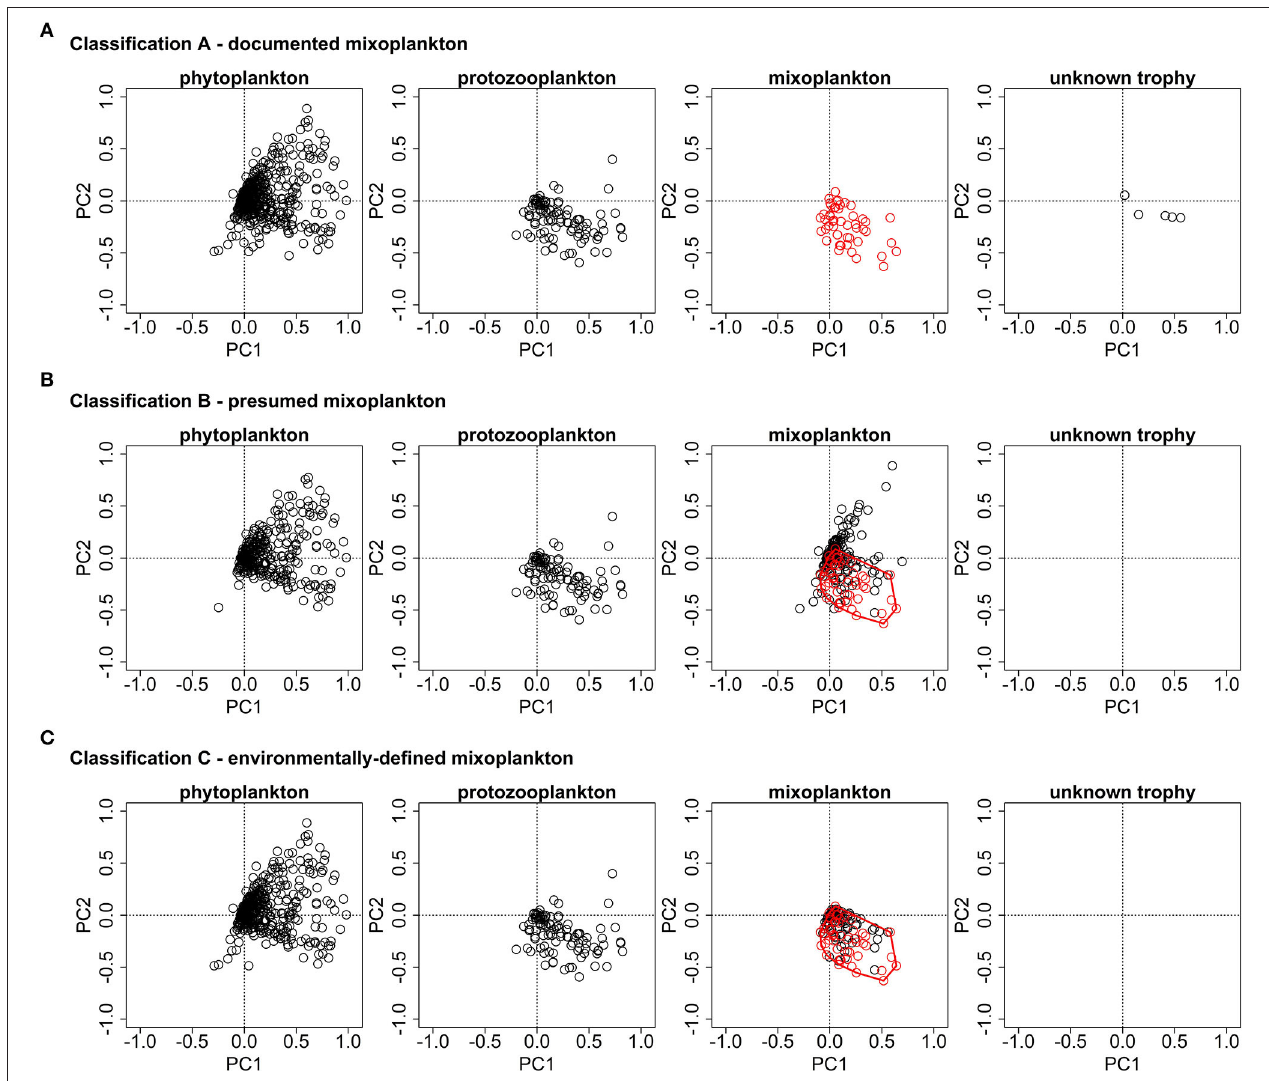
FIGURE 5 | PCA ordination plots for the species data of the three trophic classifications. (A) The documented mixoplankton (in red) are oriented toward the bottom right quadrant. (B) The presumed mixoplankton are oriented toward both right quadrants. The documented mixoplankton of (A) are displayed in red and the red polygon highlights the environmental envelope of the documented mixoplankton. (C) The documented mixoplankton are displayed in red and the additional environmentally-defined mixoplankton are displayed in black. The additional environmentally-defined mixoplankton were chosen as they lie within the environmental envelope of documented mixoplankton of (A) (displayed by the red